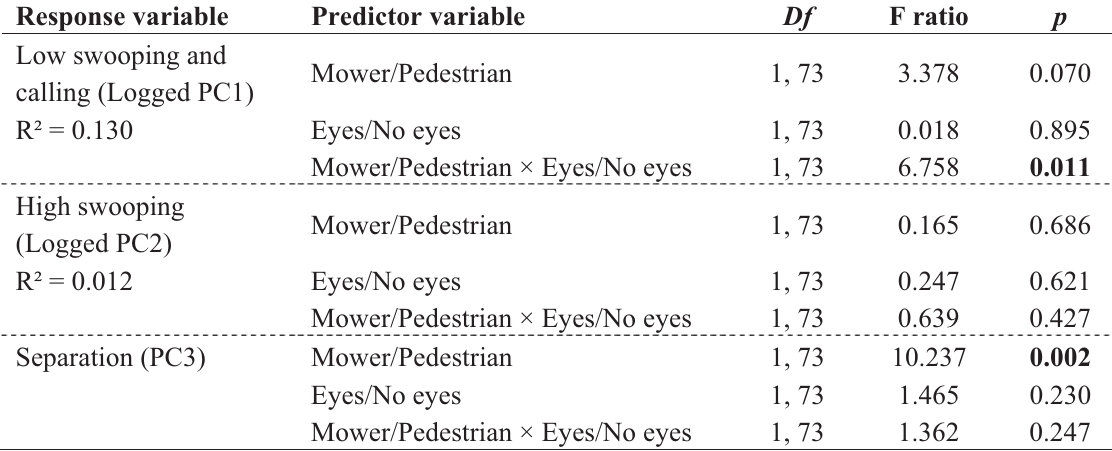
Table 3. Results of General Linear Models (GLMs) and General Linear Mixed Model (GLMM) (habitat included as a random effect for ‘separation’) investigating the influence of pedestrians vs . lawn mowers, eye stickers vs . no eye stickers, the interaction between pedestrians vs . lawn mowers and eye stickers vs . no eye stickers on parental defence variables (see Table 1). Df = degrees of freedom; significant values are emboldened.